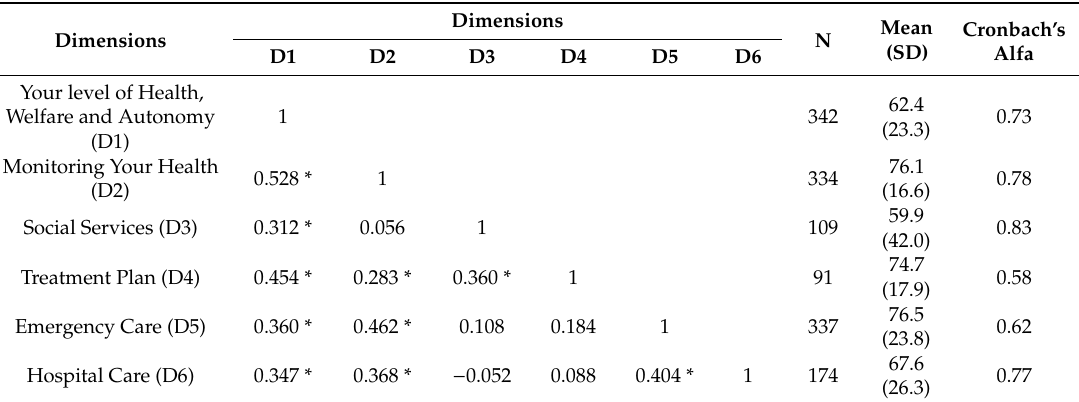
Table 3. Intercorrelation and internal